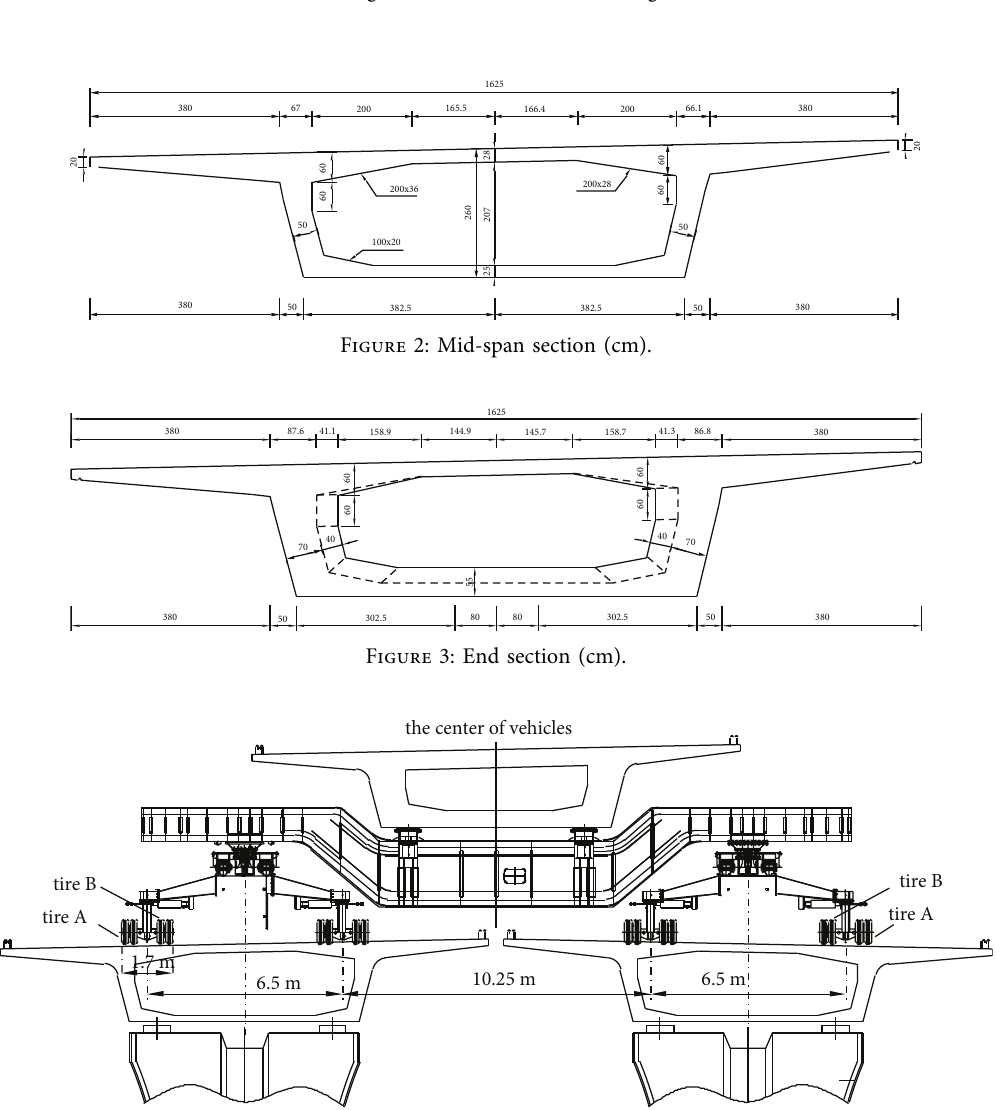
Figure 4: Box girder transport with four